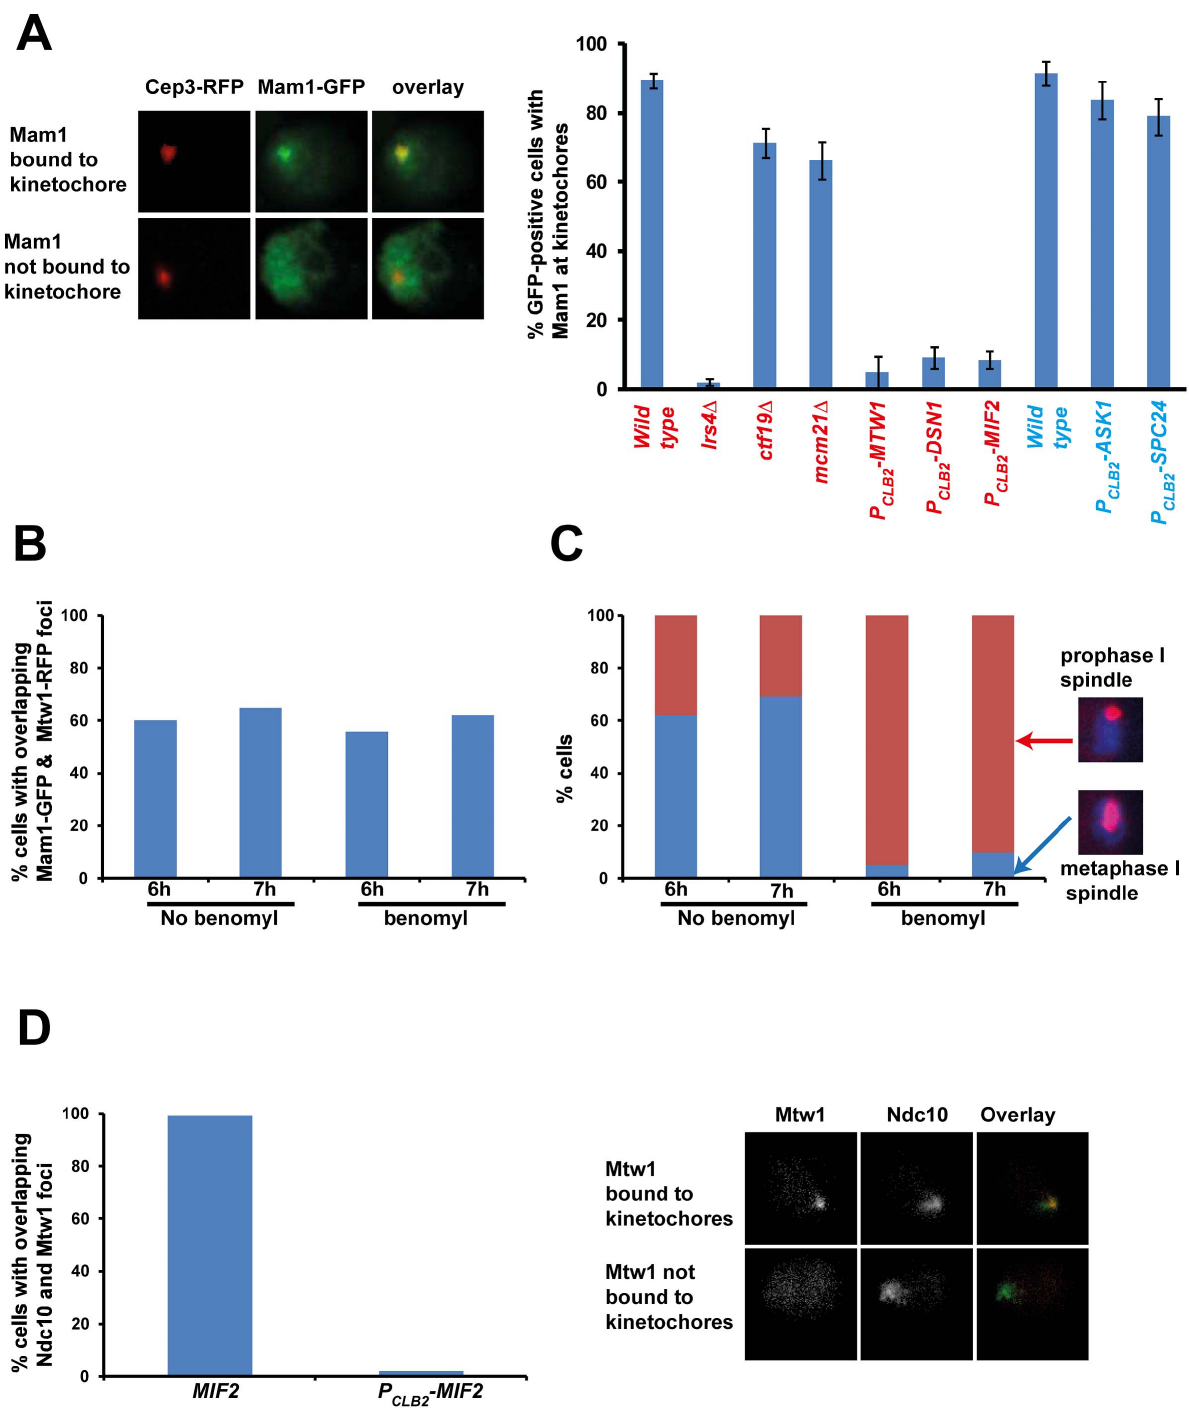
Figure 1. Monopolin localization to kinetochores requires the MIND complex and CENP-C. A) P CLB2 -CDC20 CEP3-RFP MAM1-GFP or P CLB2 - CDC20 MTW1-RFP MAM1-GFP cells and genotypically identical cells but containing either lrs4 D or ctf19 D or mcm21 D or expressing P CLB2 -MTW1 , P CLB2 - DSN1 , P CLB2 -MIF2 , P CLB2 -ASK1 or P CLB2 -SPC24 were induced to enter meiosis. Co-localization of Mam1-GFP with either Mtw1-RFP or Cep3-RFP signals was assayed after 5–8 hours in SPM. Representative image of cells with either Mam1 localized to kinetochores or where Mam1 is distributed throughout the nucleus is shown on the left. The average number of GFP-positive cells in which Mam1 co-localises with the kinetochore marker (with Cep3 in red and Mtw1 in blue) was assessed from 3 independent cultures (300 cells per experiment). B) MTW1-RFP MAM1-GFP P CLB2 -CDC20 cells were induced to enter meiosis by transferring them to SPM. After 4 hours the cultures were split into two and either benomyl (120 m g/ml) or DMSO was added to the cultures. The percentage of GFP-positive cells showing overlapping Mtw1-RFP and Mam1-GFP signals is shown in the plot. C) In situ immunofluorescence of cells from 1B was performed and cells were stained with anti-tubulin antibodies and DAPI. Percentage of cells with metaphase I/prophase I-like spindles is indicated. D) NDC10-GFP MTW1-RFP P CLB2 -CDC20 strains containing either MIF2 or P CLB2 -MIF2 were induced to undergo meiosis by transferring them to SPM. After 5 hours, cells were fixed and analysed by fluorescence microscopy. The percentage of cells with